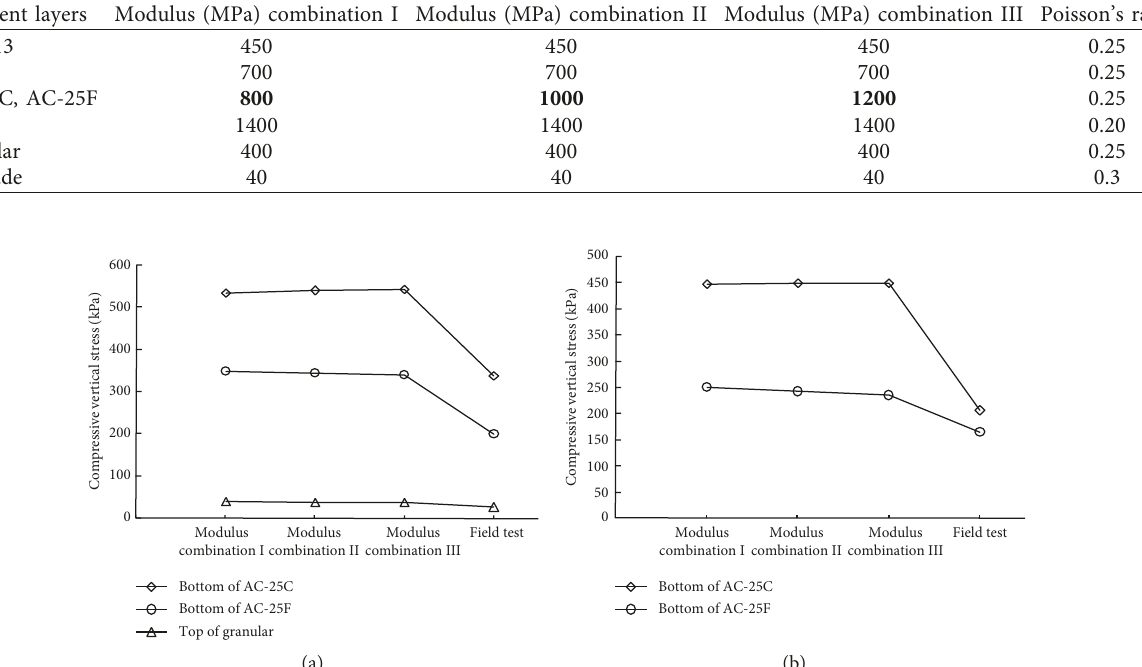
Figure 12: Comparison of theoretical vertical stress and measured vertical stress. (a) Structure I. (b) Structure